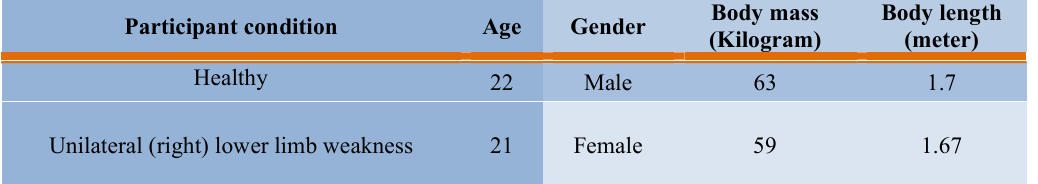
Walking conditions for sound person. Trial number Waling Description 1 st trial Walking without using the exoskeleton. 2 nd trial Walking using the